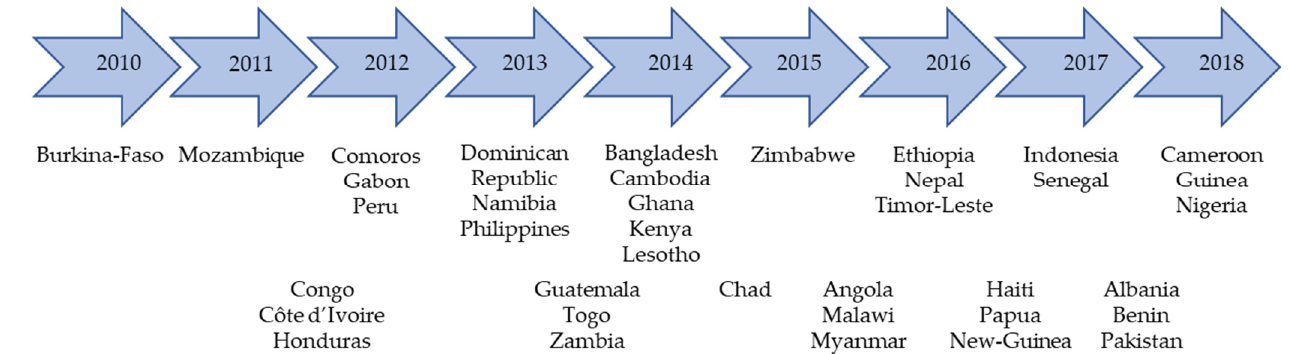
Figure 1. Countries and DHS questionnaire dates included in this study.